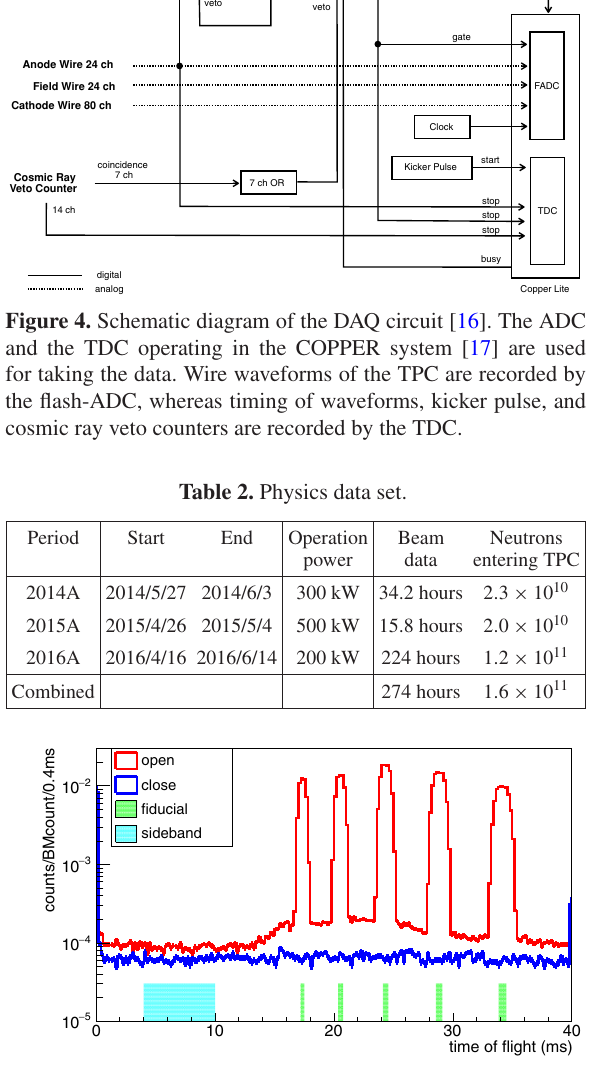
Figure 5. 3 He( n , p ) 3 H reaction events in the TPC in correlation to the neutron TOF. The red and blue histograms represent the shutter open and close data, respectively. The vertical axis is normalized by the counts of the neutron beam flux monitor. Each of the five green bands represents the fiducial time, in which a neutron bunch is completely inside the TPC sensitive region. Their durations are 0.33ms, 0.39ms, 0.46ms, 0.54ms, and 0.64 ms, in ascending order of TOF. The light blue band represents a sideband region (in the TOF range 4 ∼ 10ms), during which no neutron bunch is inside the TPC. The time t = 0 defines the moment at which the proton beam hits the spallation target in the MLF. The spallation process causes a large background, which can be seen as the peaks at t = 0ms and t =